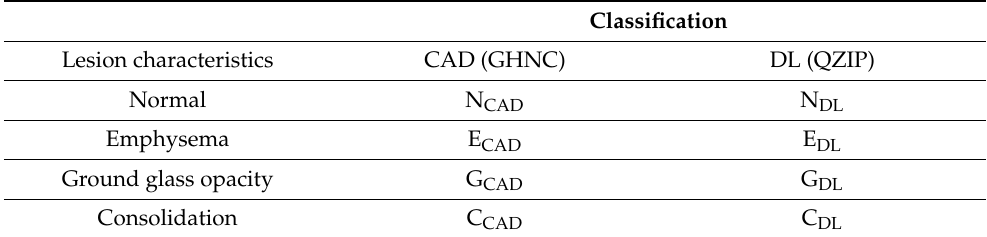
Table 2. Classification of the lung lesions according to the CAD and DL-based